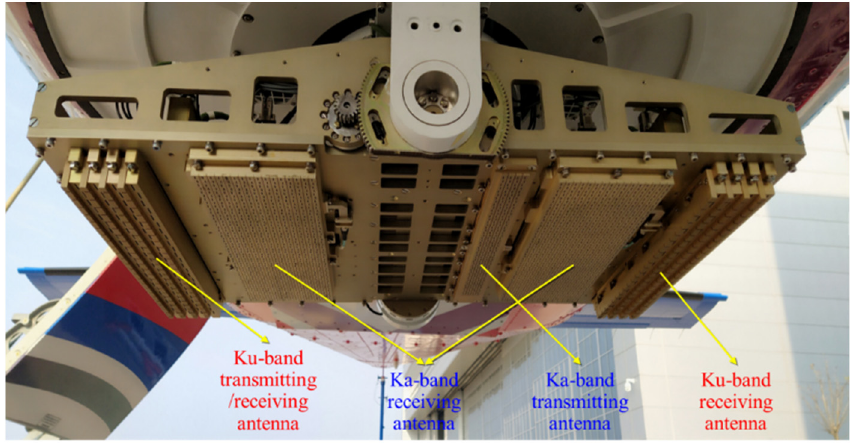
Figure 1. The antennas of the airborne SAR altimeter system.